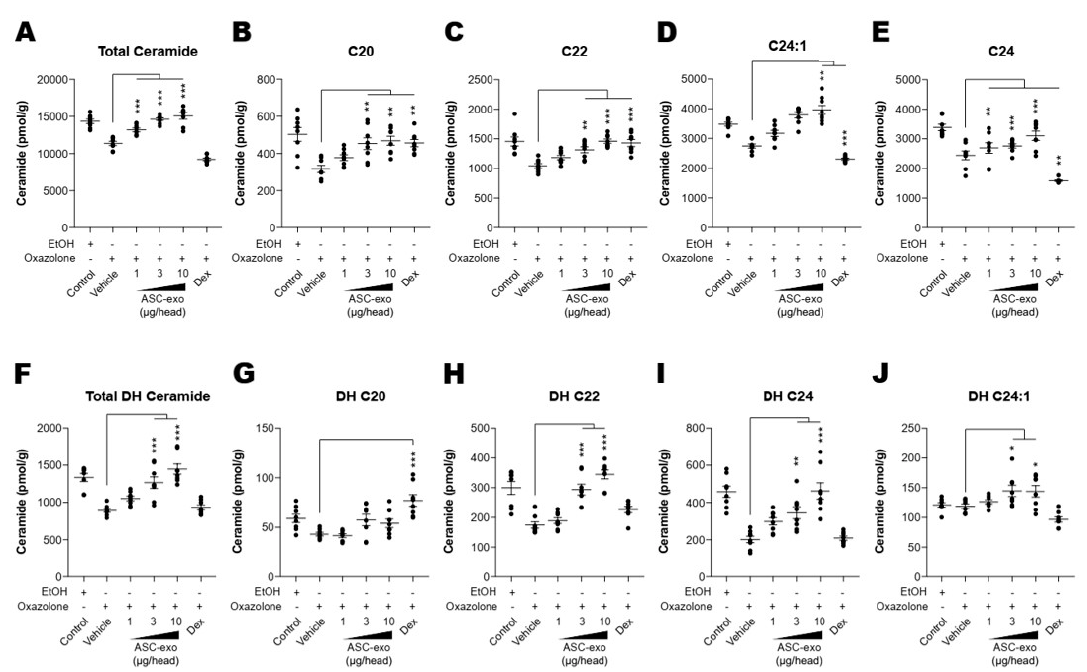
Figure 5. ASC-exosomes increase the level of ceramides in skin lesions. ( A–J ) Mass spectrometry analysis of ceramide and dihydroceramide species. Lipids were extracted from the homogenate of dorsal skins corresponding to 1 mg protein. n = 8 per group. Error bars depict the SEM. *: p < 0.05, **: p < 0.01, ***: p < 0.001 vs. vehicle. Dex: dexamethasone.